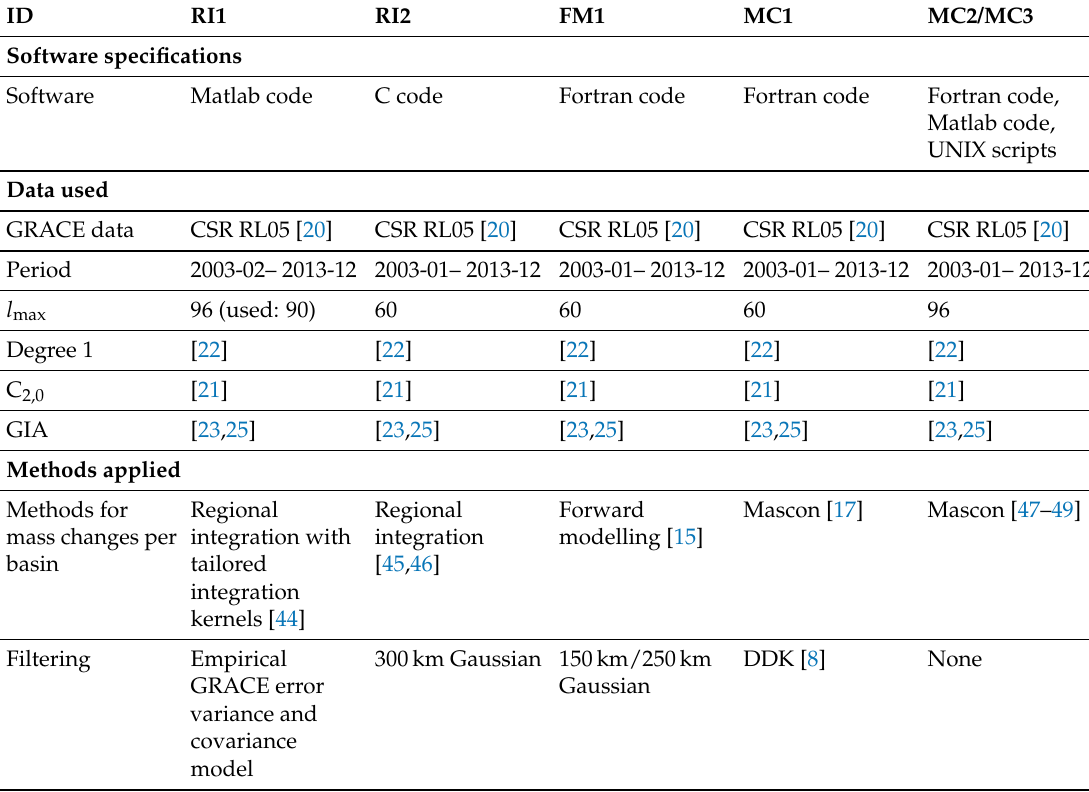
Table 3. Selected details on the data sets and the processing strategy used by each participating